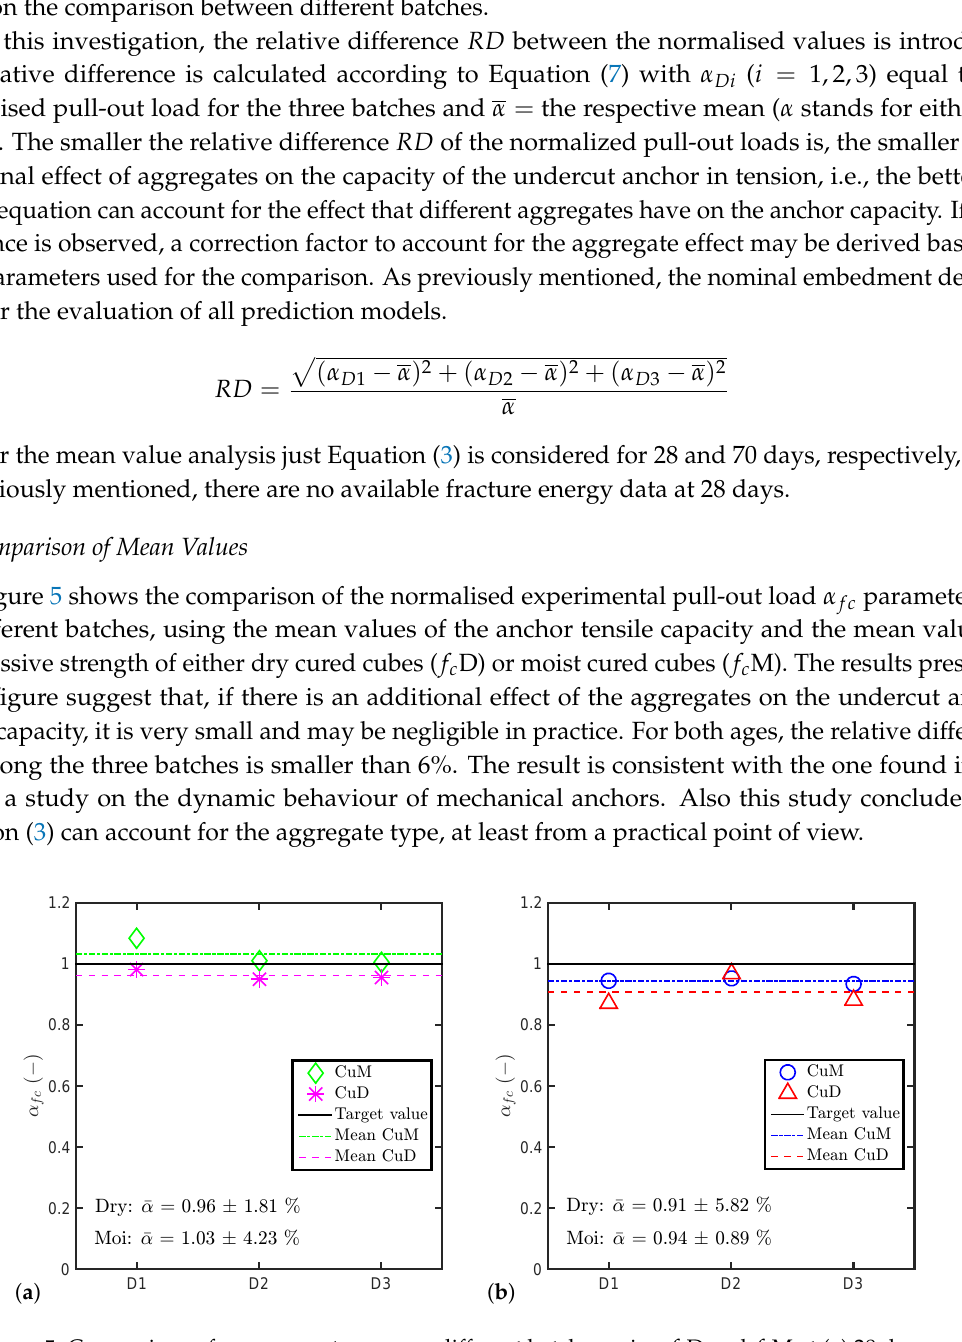
Figure 5. Comparison of α fc parameter among different batches using f c D and f c M at ( a ) 28 days and ( b ) 70